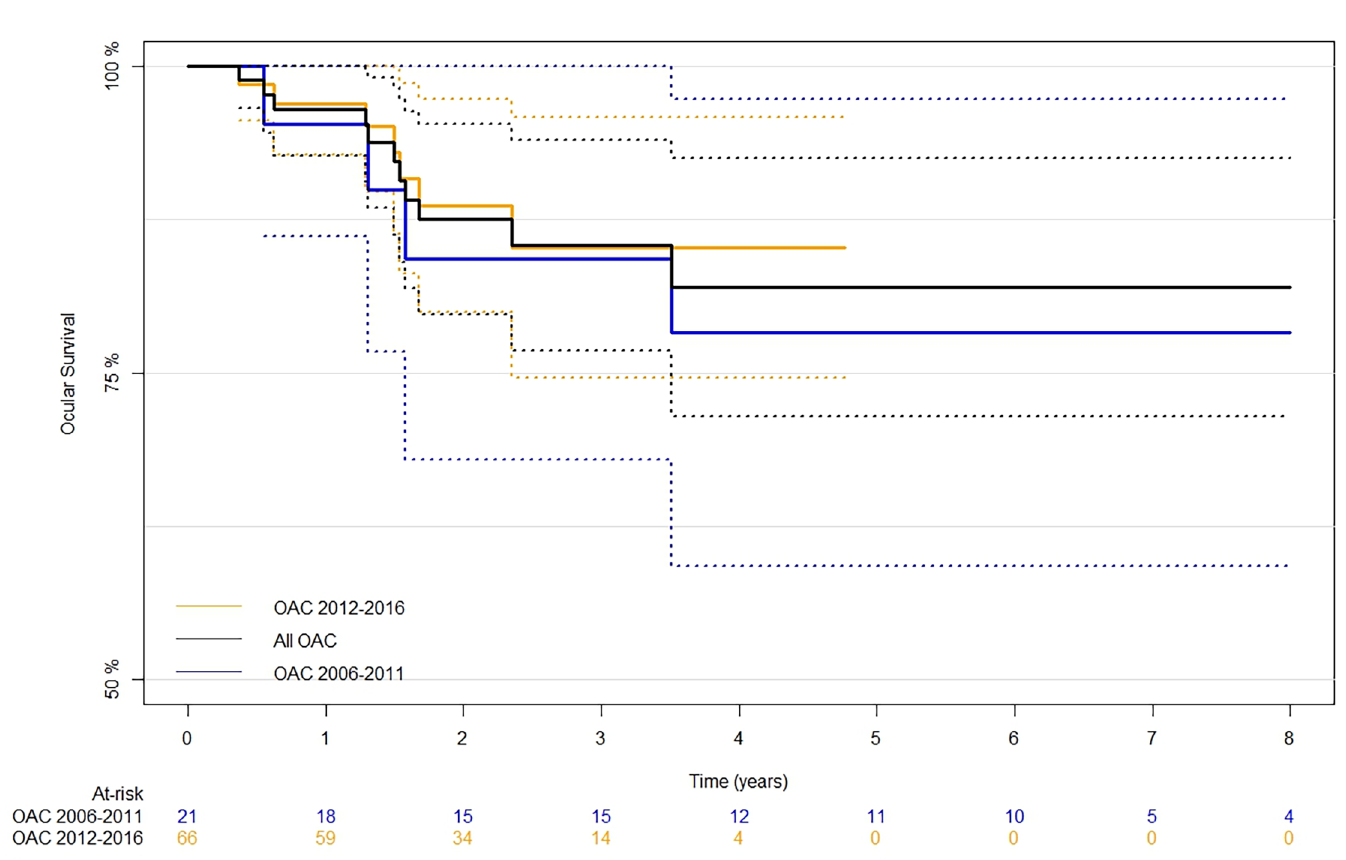
Fig 4. Kaplan-Meier curve of the ocular survival in OAC-treated total retinal detachment eyes, among all 87 eyes, 21 eyes treated within the first 5 years (2006– 2011), and 66 eyes treated within the most recent 5 years (2012–2016). The dotted lines represent the 95% confidence interval for the survival